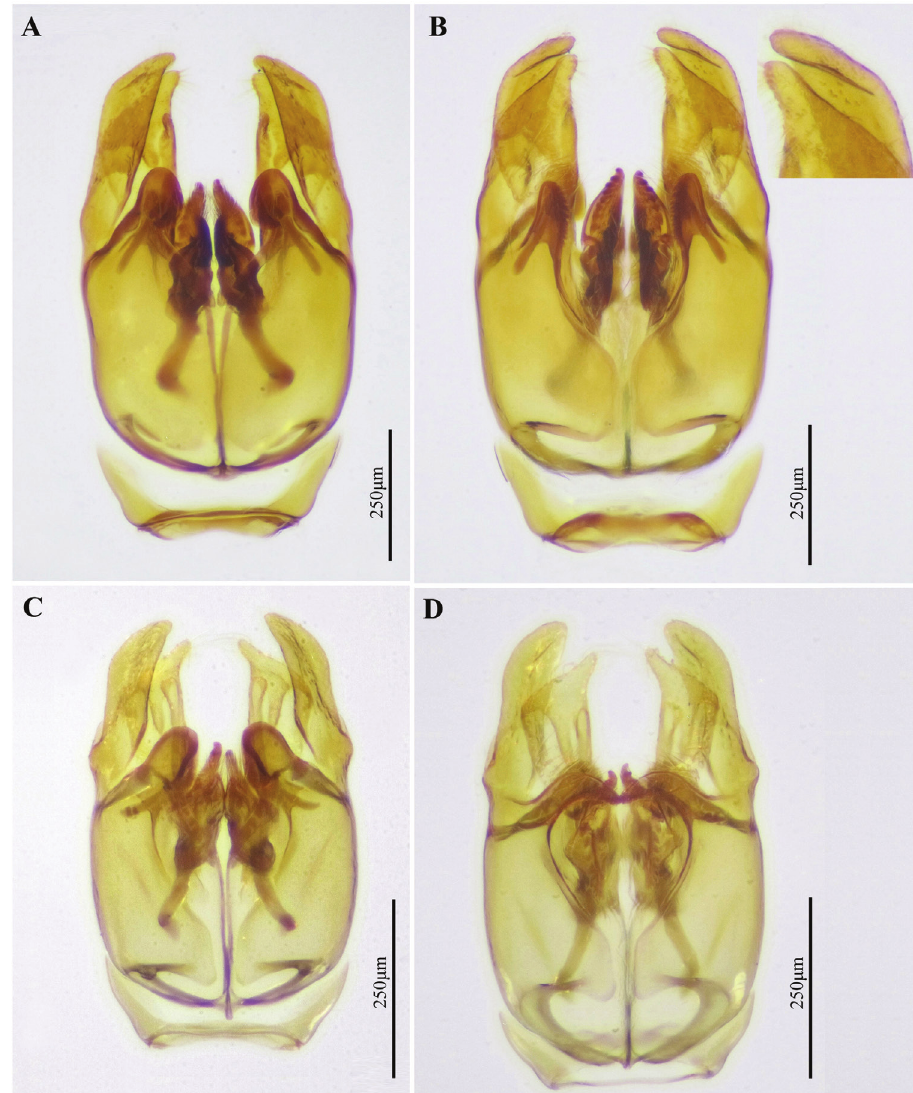
Figure 33. Male genitalia A, B Pseudophotopsis aurea (Klug), dorsal and ventral views, respectively C, D P . dhofarensis sp. nov., dorsal and ventral views,